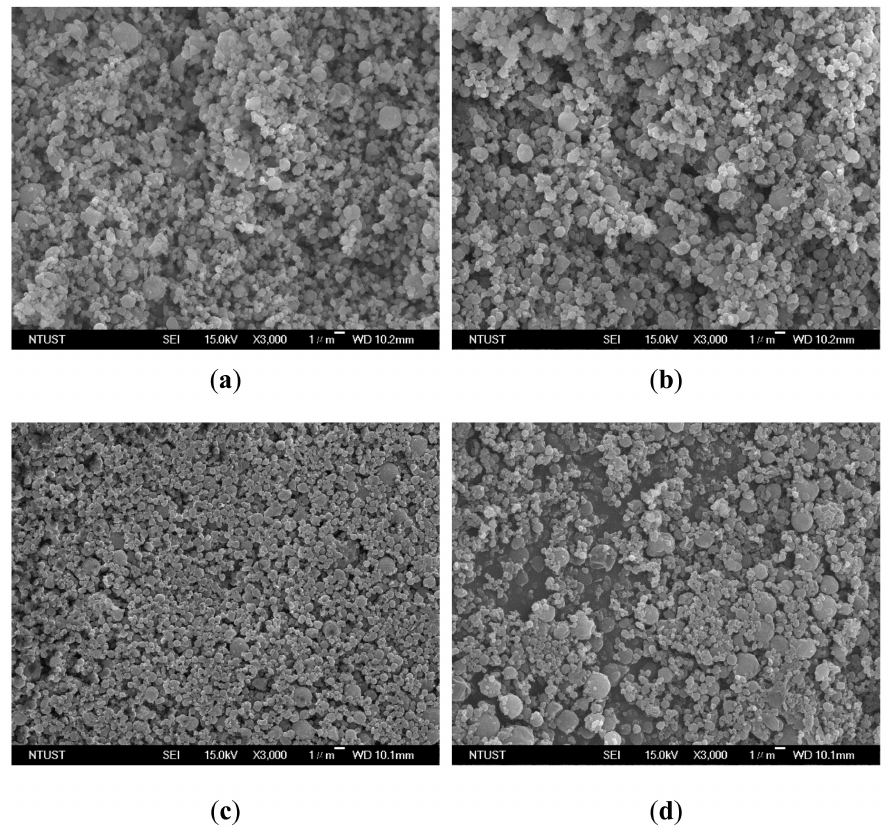
Figure 6. FESEM images of PEG particles produced by the LTSAA process at di ff erent volume flow ratios ( R ): ( a ) R = 0.8; ( b ) R = 1.5; ( c ) R = 2; and ( d ) R =